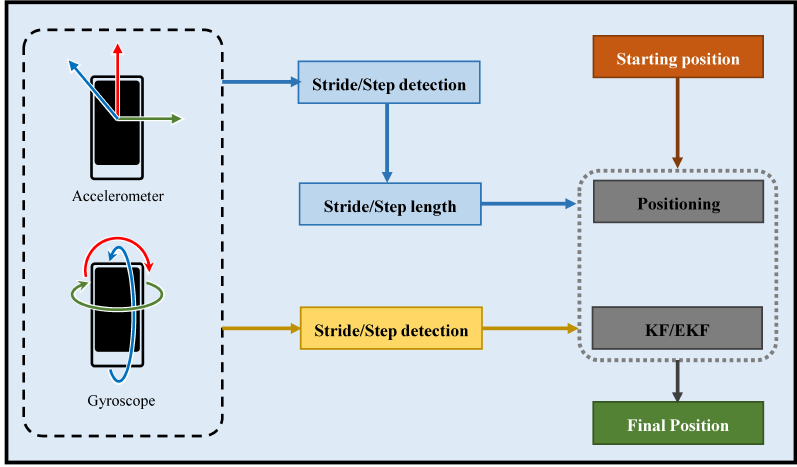
Figure 3. The working architecture of pedestrian dead